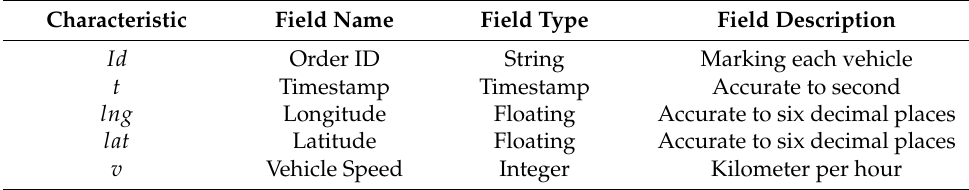
Table 1. The detailed data attributes of the FCD